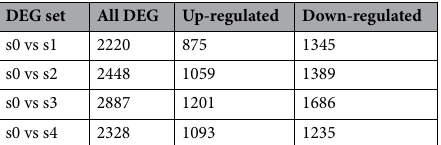
Table 1. Statistics of number of differentially expressed genes.